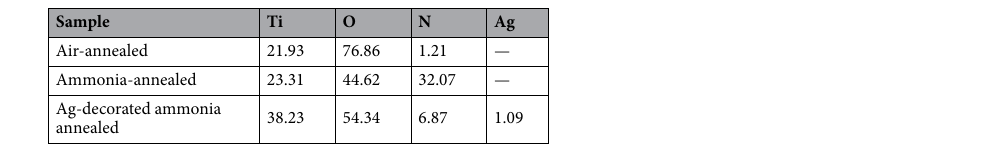
Table 1. Atomic percentage of Ti, O, N and Ag for the air-annealed, ammonia-annealed, and Ag-decorated ammonia-annealed samples as extracted from